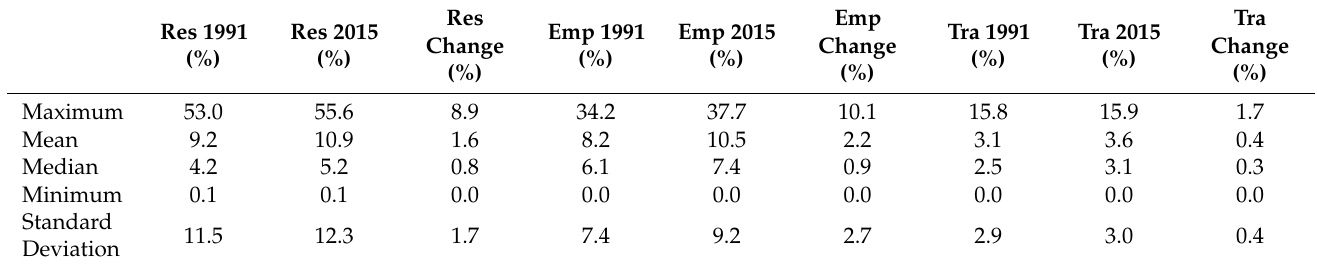
Table 4. Statistics of Residential, Employment, and Transportation over